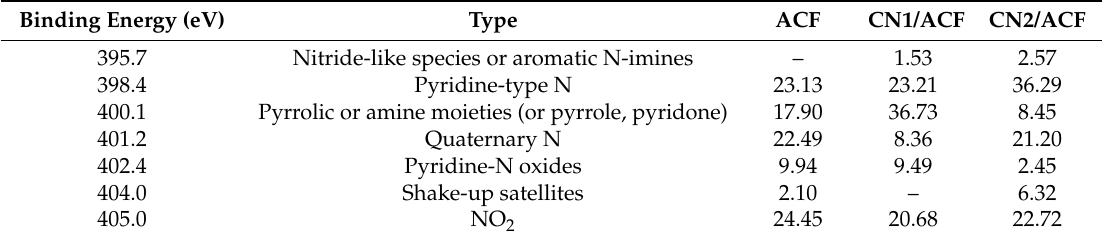
Table 2. Results of the fits of the XPS N 1s region, values given in at% of total intensity.